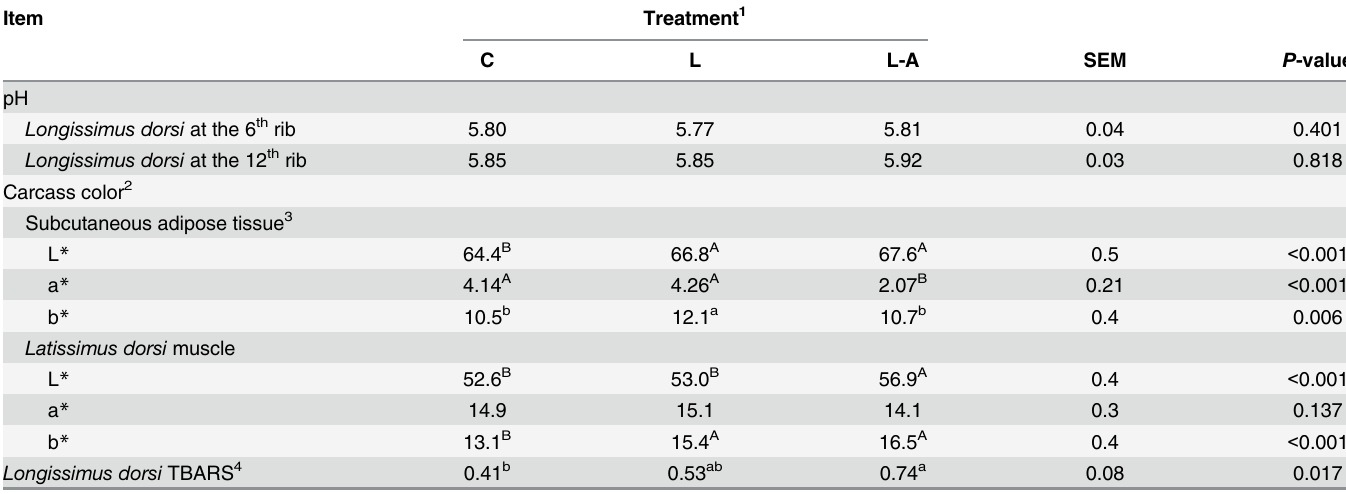
Table 7. Effects of addition of linseed or linseed and marine algae to the diet on meat quality traits of Navarra breed